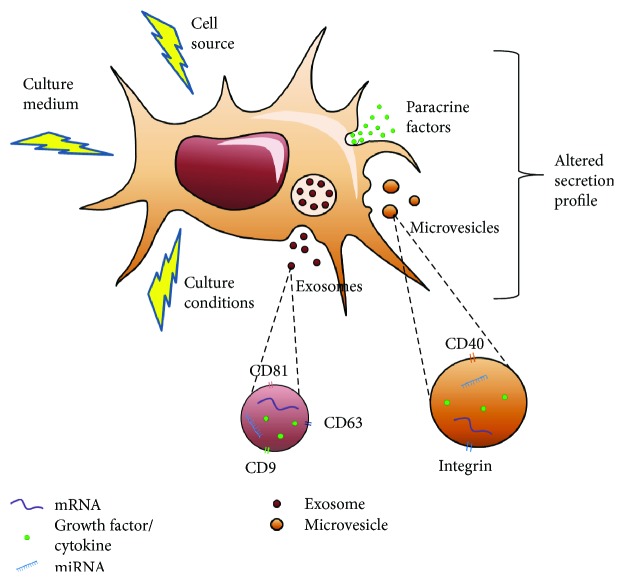
The secretion profile of MSCs may be altered by several factors including culture medium, cell source (i.e., bone marrow and adipose) and culture conditions (i.e., 3D cultures, hypoxia, and mechanical stimuli). The therapeutic portion of the secretion profile includes the amount and composition of paracrine factors and EVs (microvesicles and exosomes). The composition within EVs is also altered which includes RNAs such as mRNAs and miRNAs, growth factors, and cytokines.